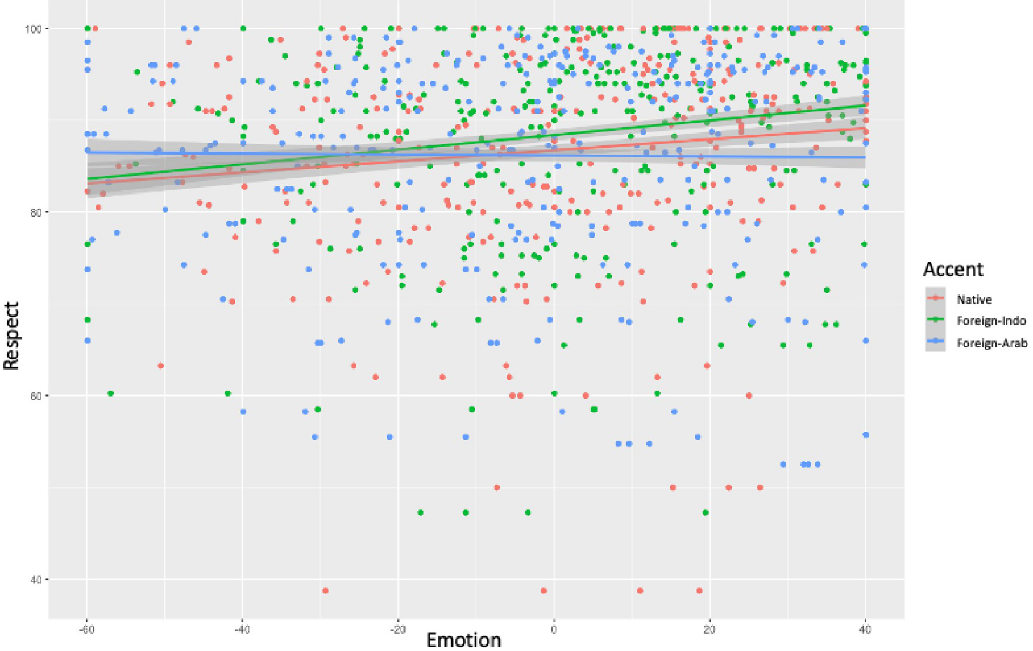
Fig 1. Interaction between Accent (Native Accent vs. Foreign-Indo vs. Foreign-Arab) and Emotion (mean for anger, disgust, discomfort, sadness, and preoccupation centered) on Respect.